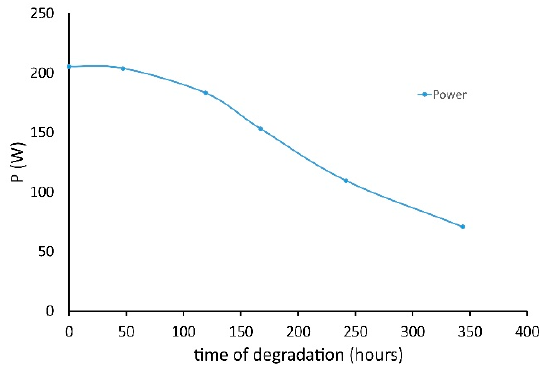
Figure 11. Change of power of PV module due to PID.